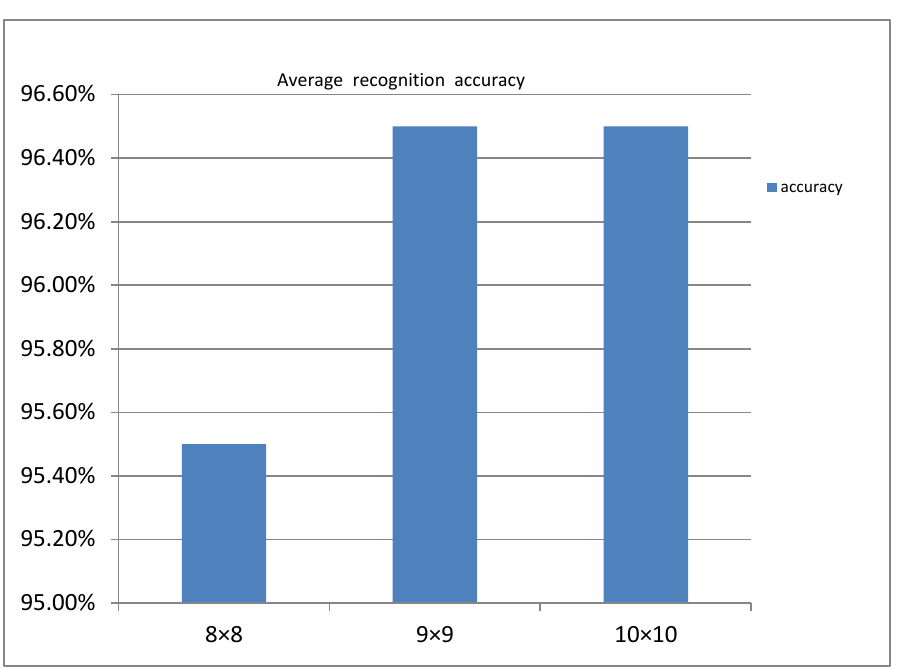
Figure 6. Average recognition rate under different convolution kernel sizes.